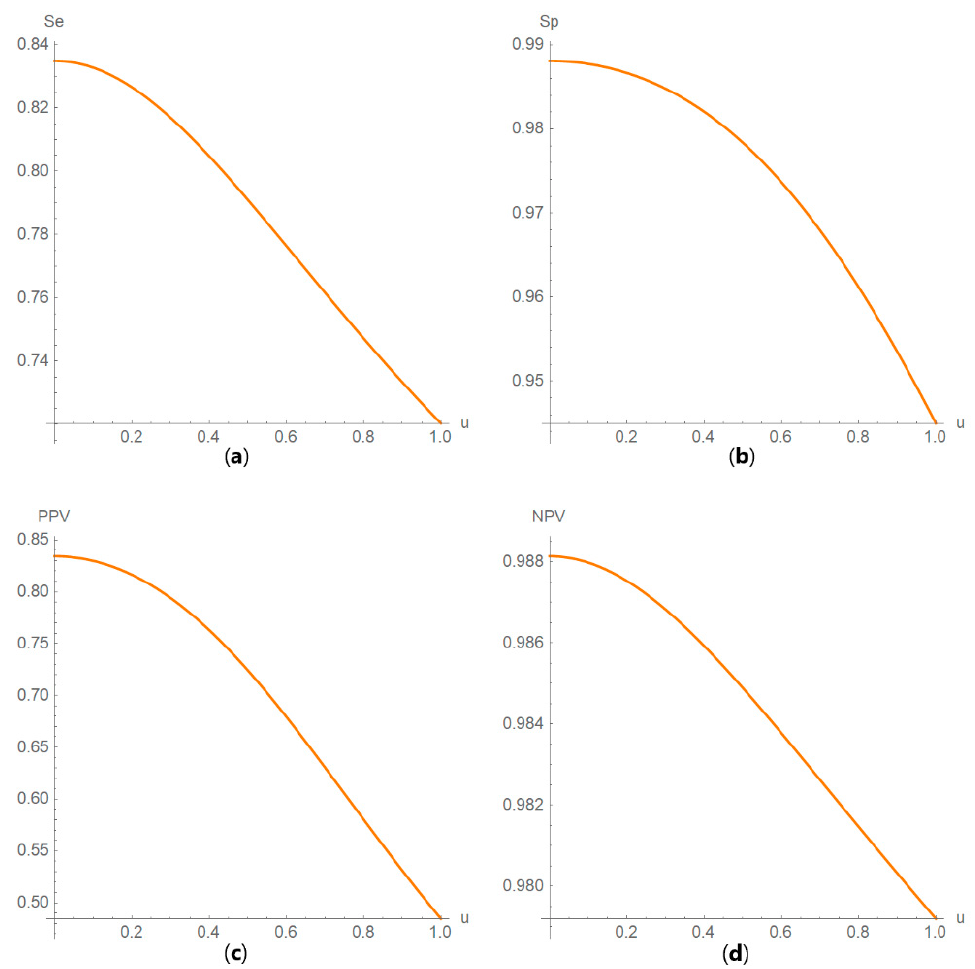
Figure 12. DAM against uncertainty plots. Plots of ( a ) sensitivity ( Se ), ( b ) specificity ( Sp ), ( c ) positive predictive value ( PPV ) and ( d ) negative predictive value ( NPV ) against standard measurement uncertainty ( u ) curves, with the respective parameters in Table 4.